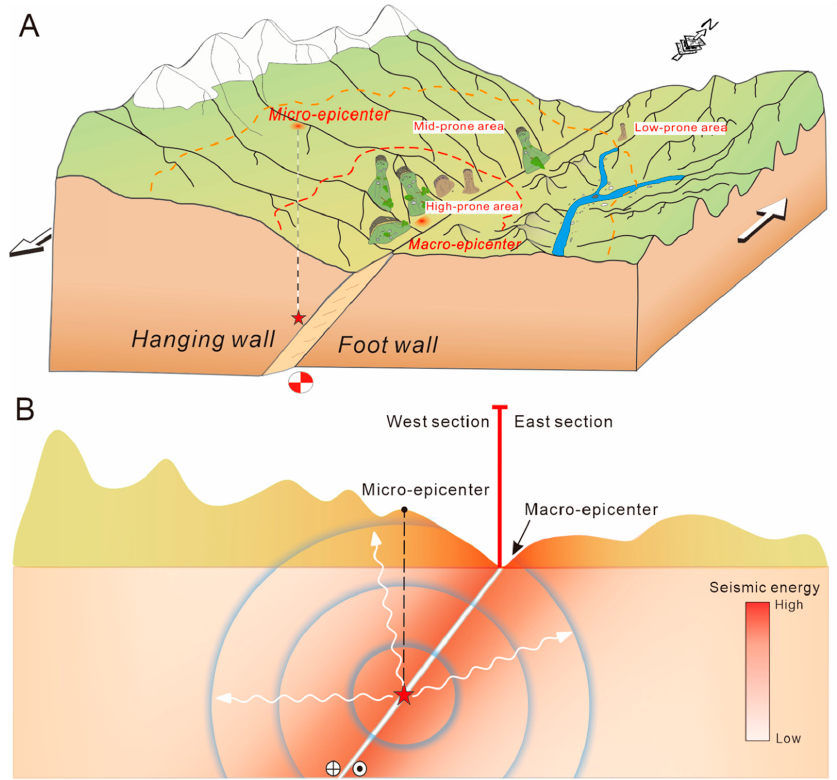
Figure 17. Schematic Diagram of the 2022 Luding Mw6.6 earthquake. ( A ) three-dimensional focal mechanism; ( B ) propagation process of earthquake energy. mechanism; ( B ) propagation process of earthquake